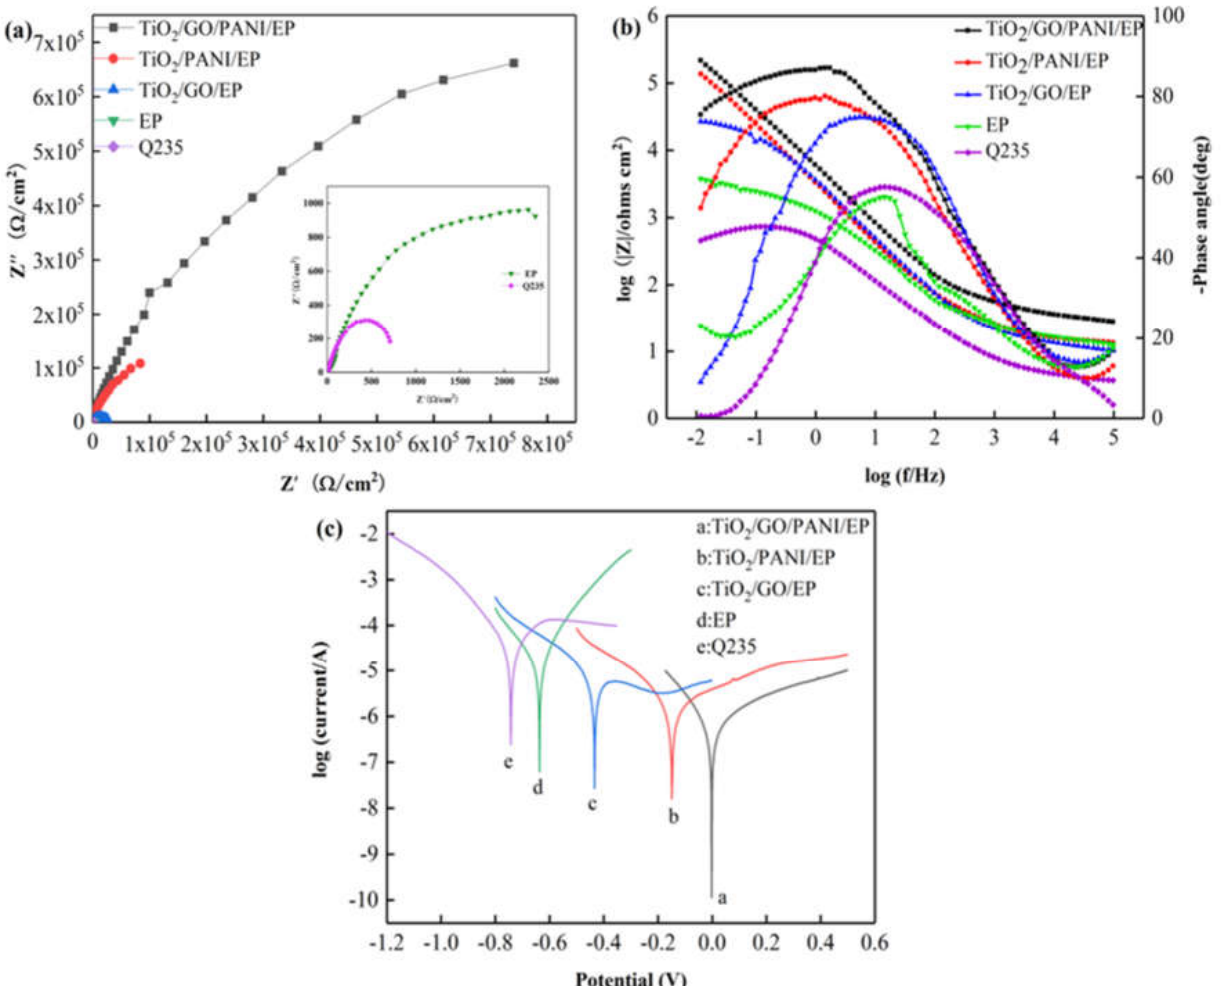
Figure 6. The EIS and Tafel curves for the EP, TiO 2 /GO/EP, TiO 2 /PANI/EP, and TiO 2 /GO/PANI/EP composites coated Q235 in the dark in 3.5 wt % NaCl aqueous solution under light off ( a ) Nyquist plot, ( b ) Bode and Phase plot, ( c ) Polarization curves.